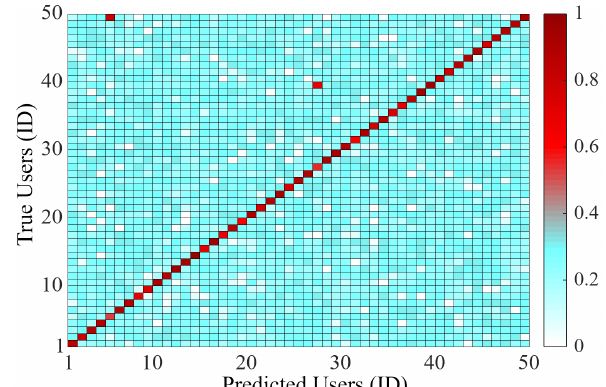
Figure 10. Confusion matrix for 50 Users. Among the 50 users, only two users were mispredicted, and the overall accuracy is up to